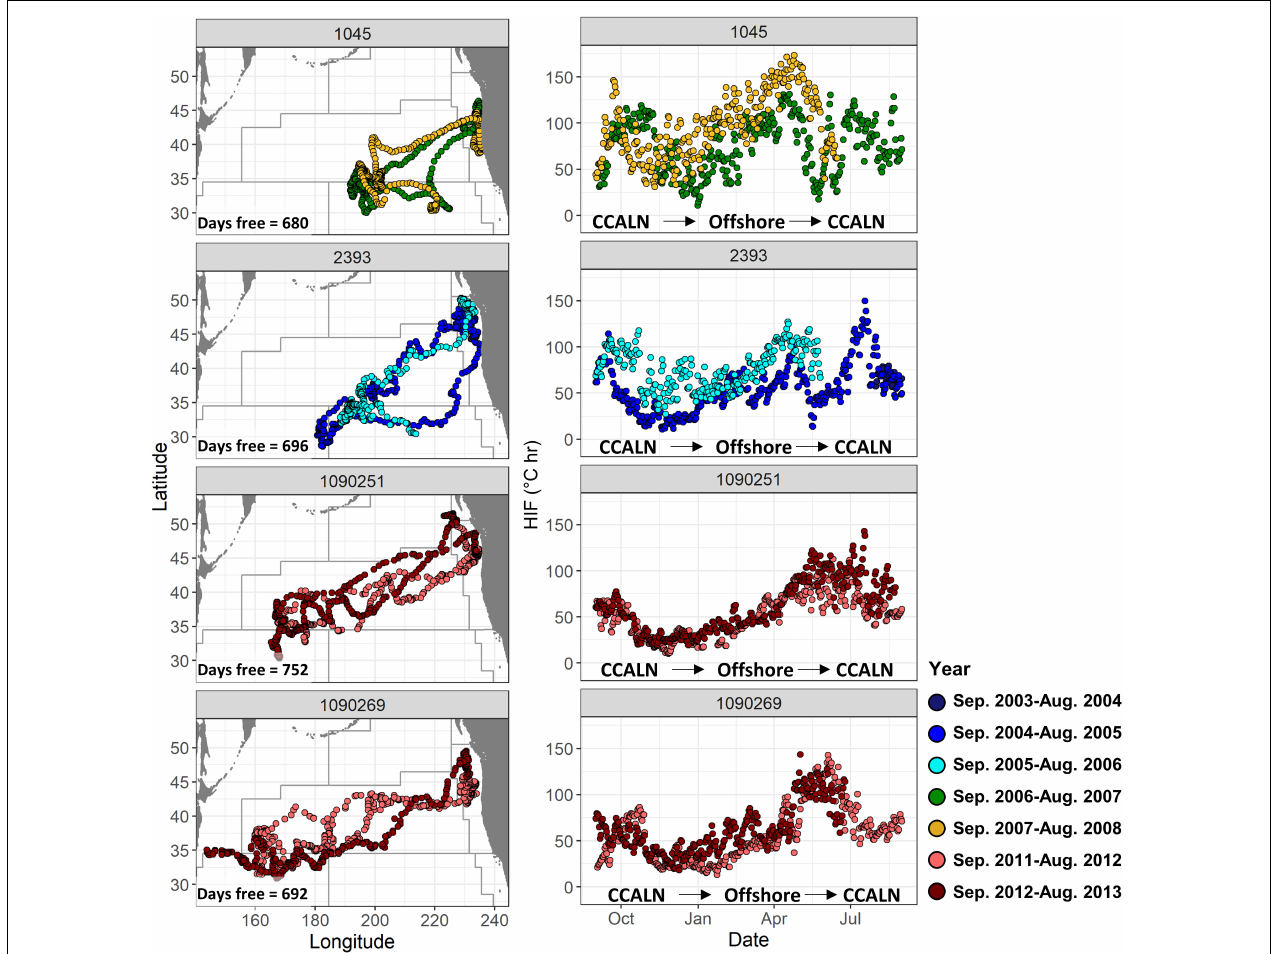
FIGURE 5 | Left: daily locations, and right: daily mean HIF for the 4 fish which were at large the longest, during both years at liberty. Years were defined from September 1st through August 31st, to coincide with typical migration timing leaving and returning to the West Coast. Boundaries of modified Longhurst regions from Figure 1 are also shown. “CCALN” denotes the northern California